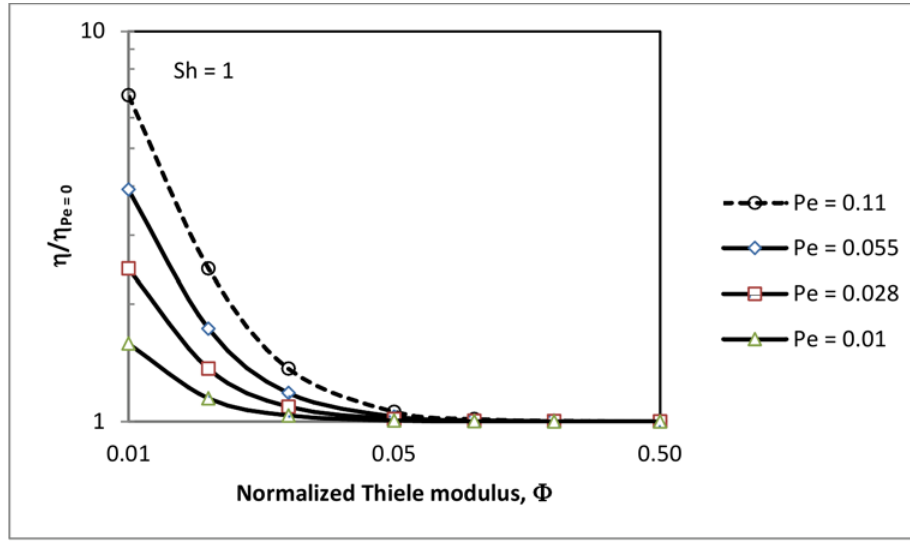
Fig 4. Relative increase in effectiveness factor vs normalized Thiele modulus at different Peclet numbers.